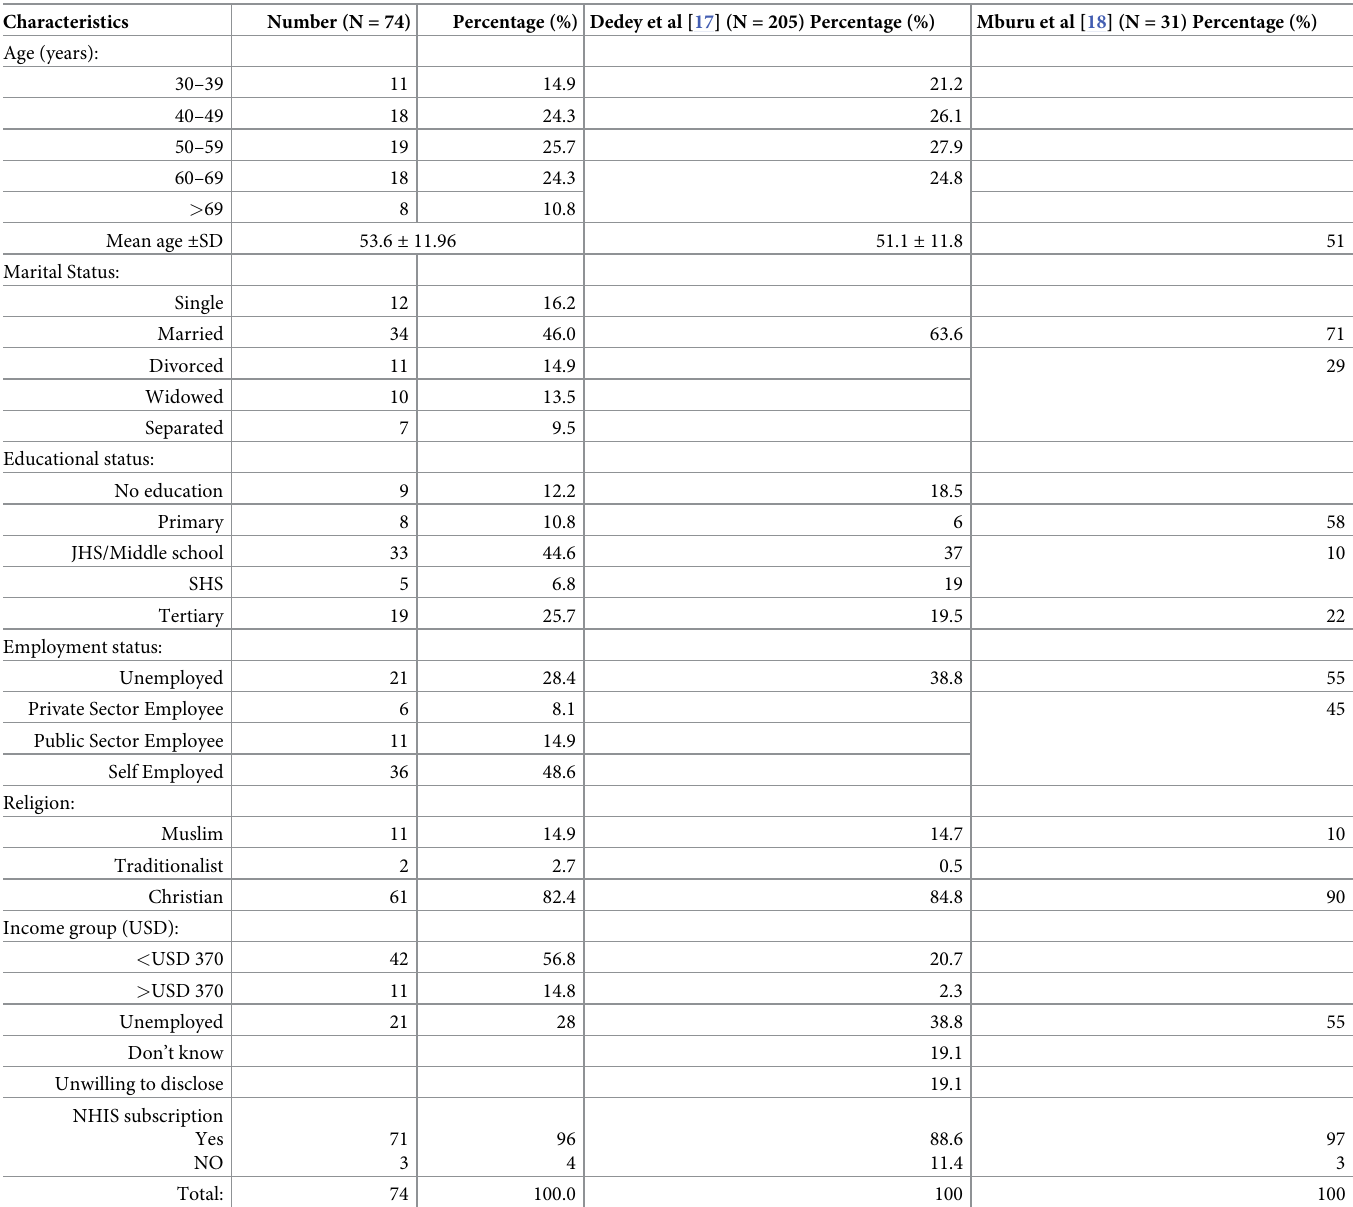
Table 2. Socio-demographic characteristics of breast cancer patients.